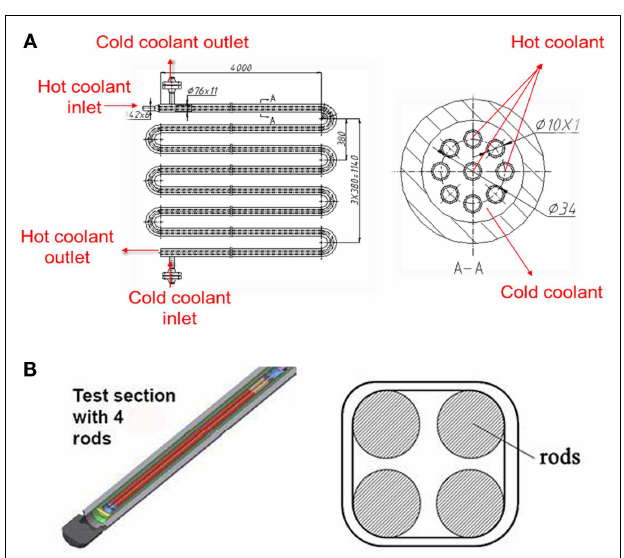
FIGURE 1 | SWAMUP test facility .